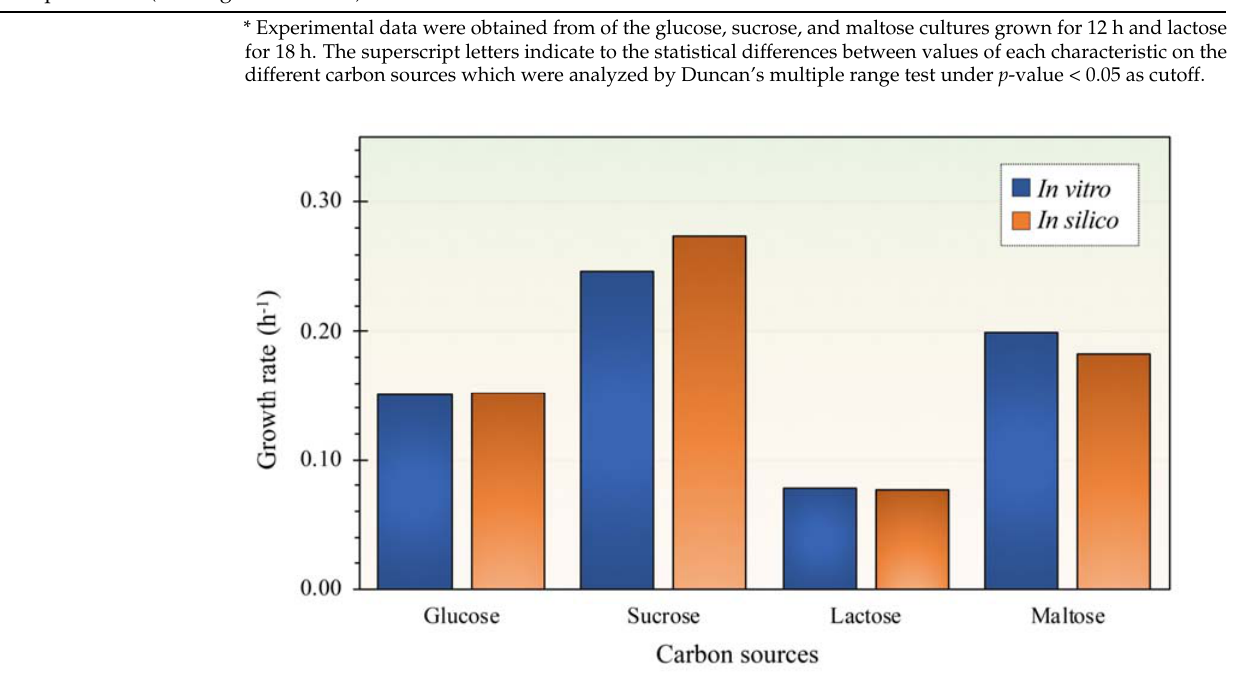
Figure 3. Model validation by comparison of growth rate (h − 1 ) between in silico data and in vitro data across different carbon sources.